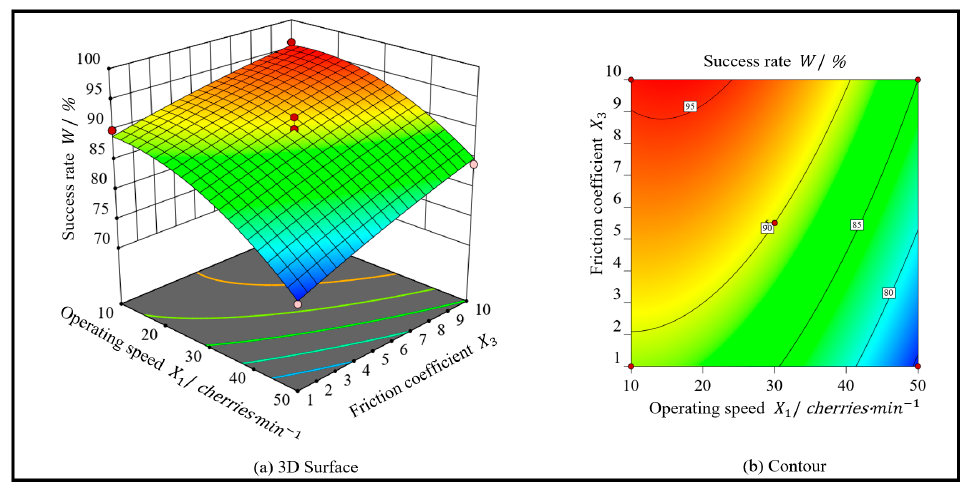
Figure 12. Effects of operating speed and Young’s modulus on success rate of sweet cherries.